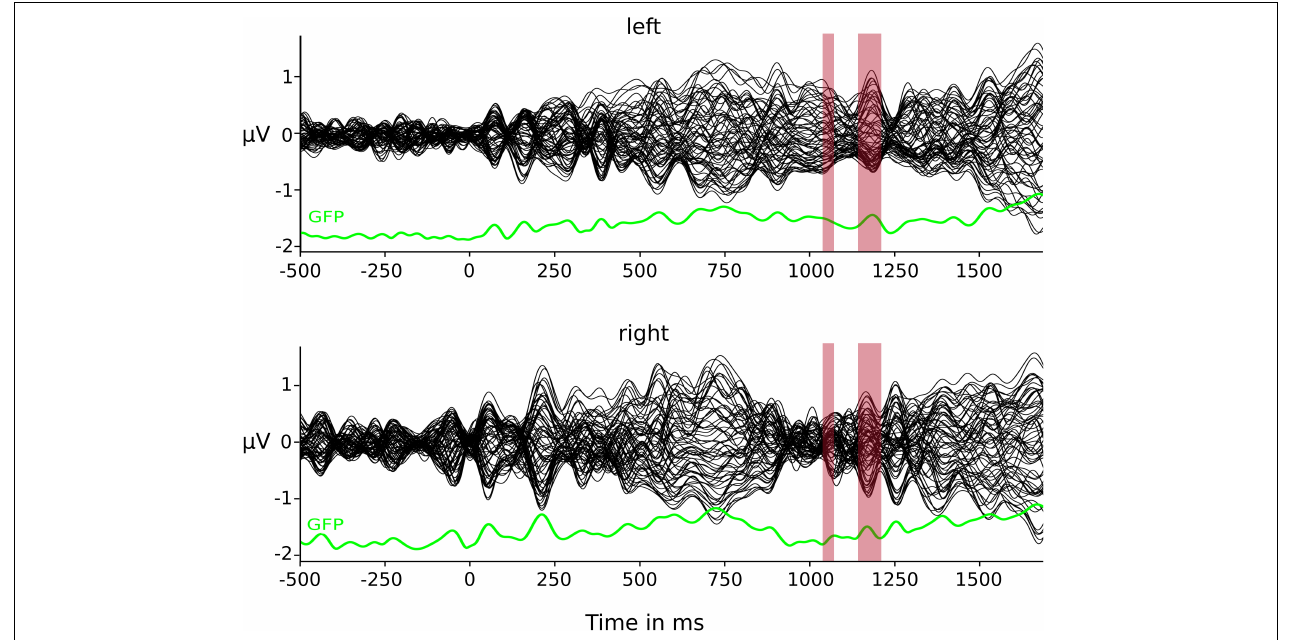
FIGURE 2 | Butterfly plots of group CSERP data. Condition-specific group averages for the left- and right-sided conditions. Each line represents one electrode. In green depicted below each group CSERP is the respective global field power (GFP). Red highlights represent time window of significant GMD